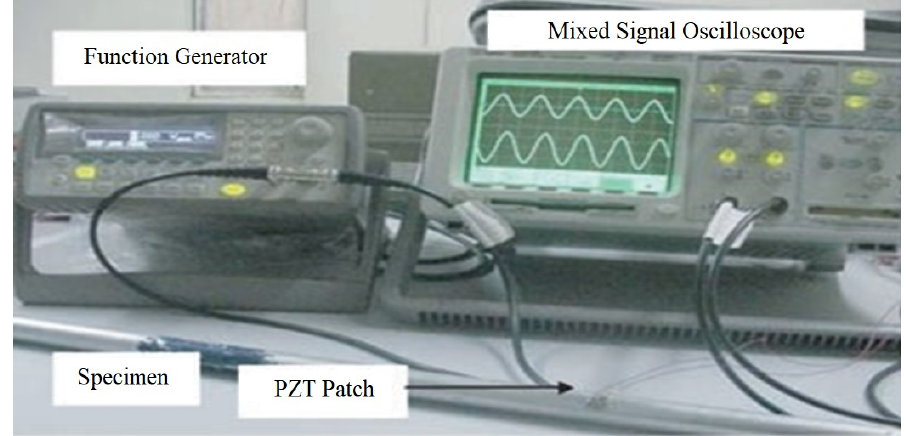
Figure 5. Practical setup for impedance type destruction analysis method.